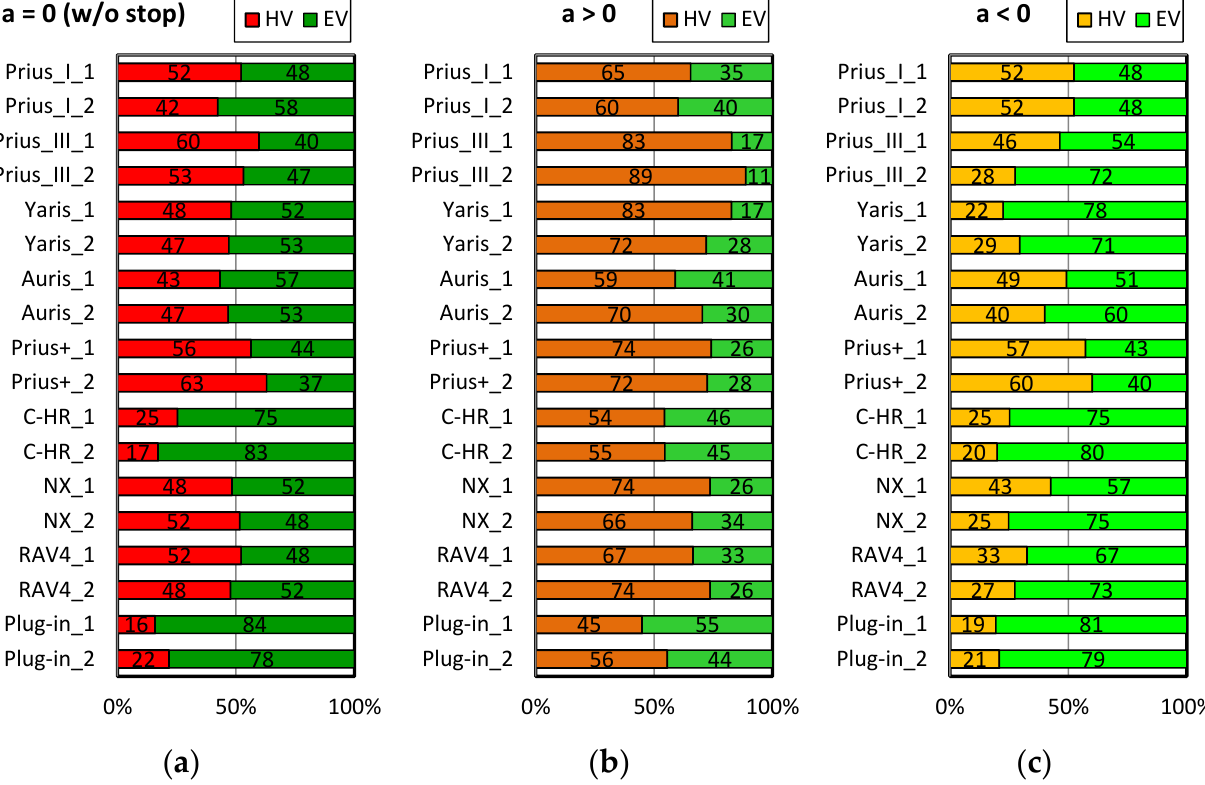
Figure 9. The share of hybrid and electric mode use in the three driving phases: ( a ) constant speed; ( b ) acceleration; ( c ) braking.